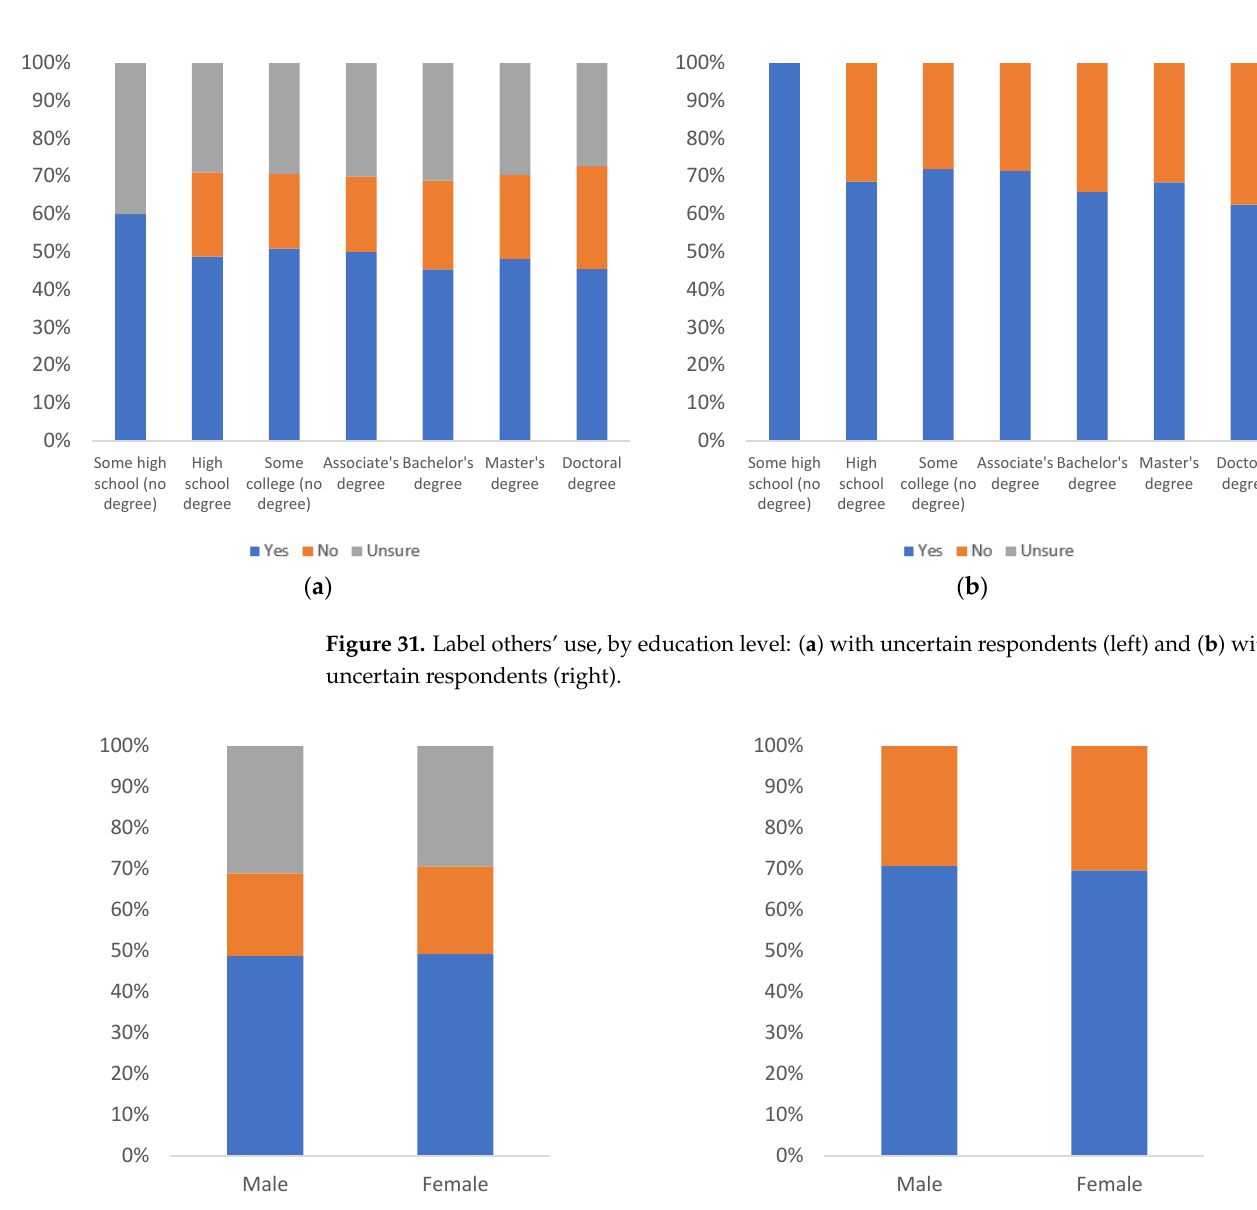
Figure 30. Label others’ use, by age group: ( a ) with uncertain respondents (left) and ( b ) without uncertain respondents (right).